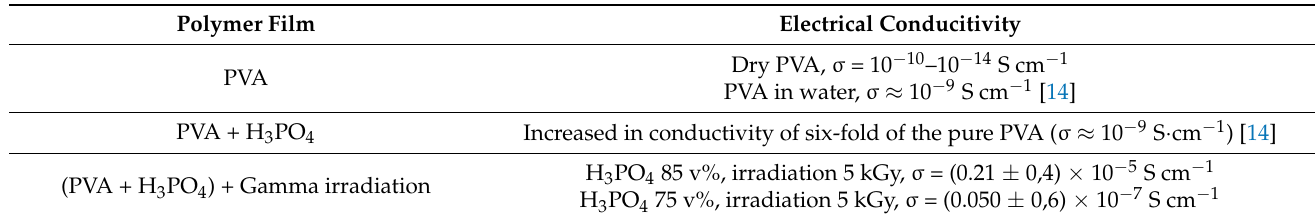
Table 2. Conductivity polyvinyl alcohol-based